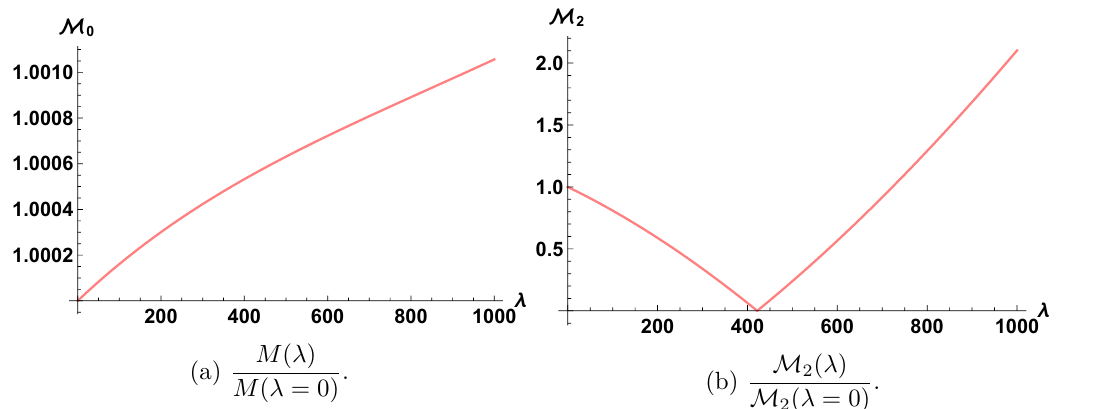
Figure 5 : For n = 1 , h = 433 / 500 , x = 3 , we plot the normalized mass M ( λ ) /M ( λ = 0) and M ( λ ) / M ( λ = 0) . There is no maximum value for λ in this case. (Note that there 2 2 is an “accidental symmetry” at λ ≈ 421 . 68 at which the quadrupole M for this microstate